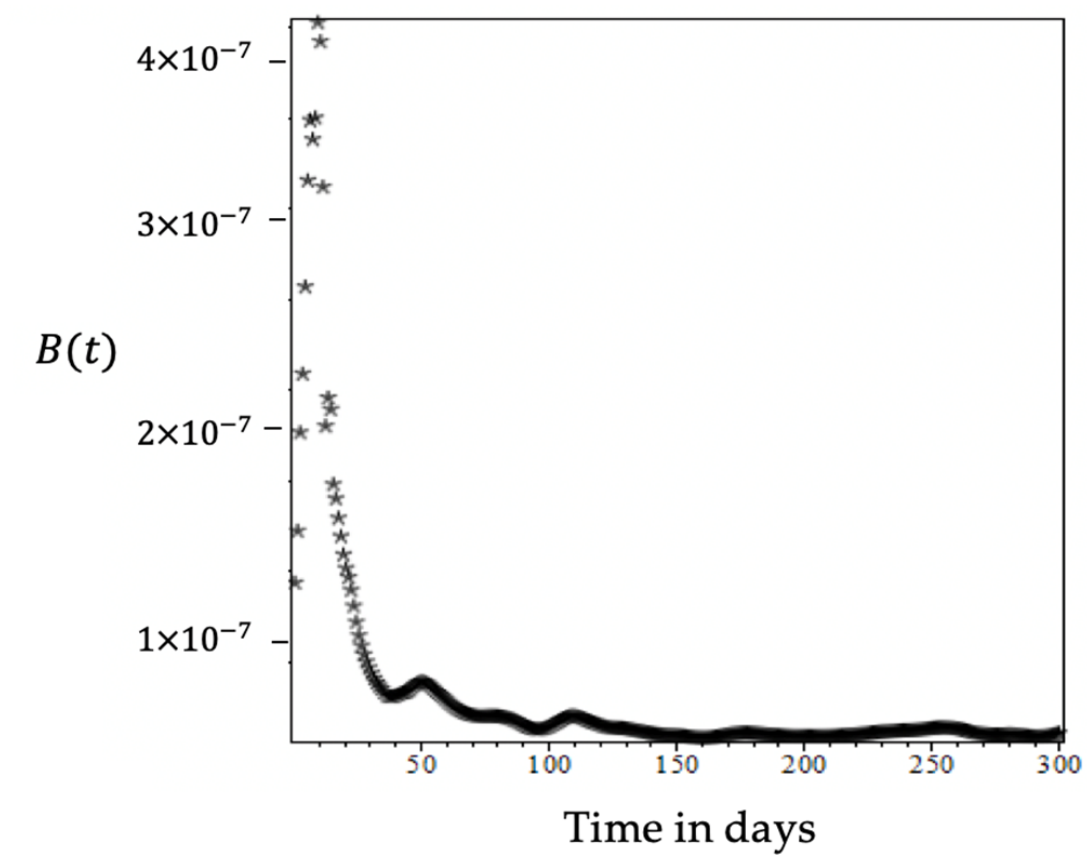
Figure 3. Time development of the transmission rate of the symptomatic population, 0 ≤ 𝑡 ≤ 300 .